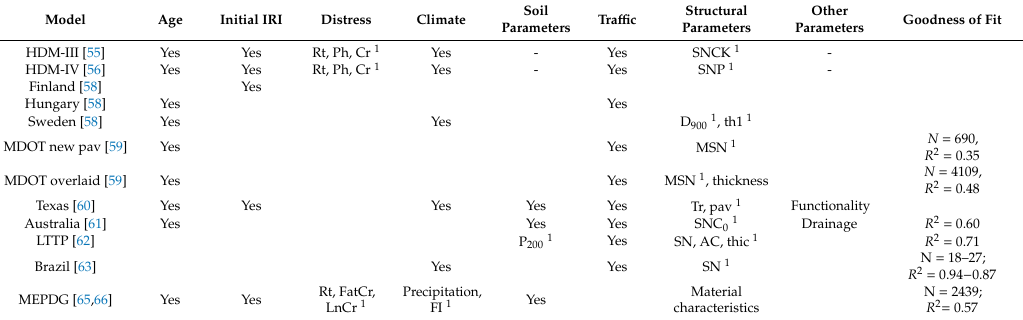
Table 1. Summary of independent variables considered in IRI models.